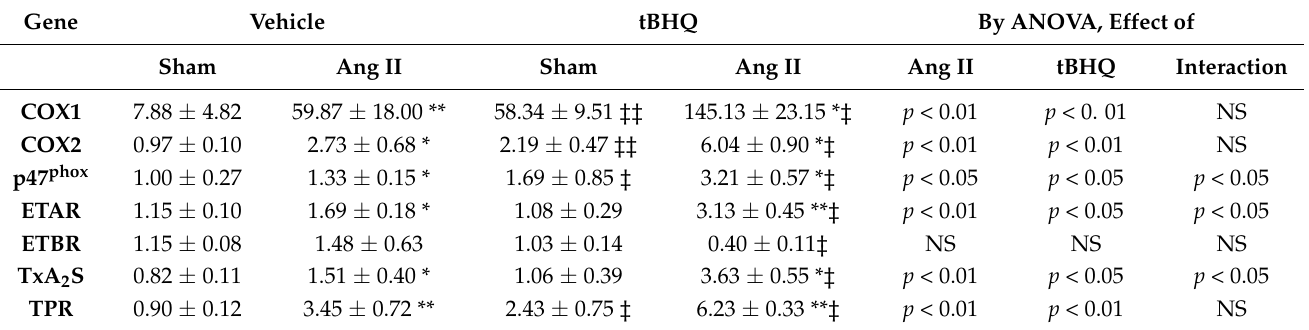
Table 1. mRNA expression in mouse mesenteric microarterioles; effects of 3 days of angiotensin II (Ang II) infusion or tBHQ